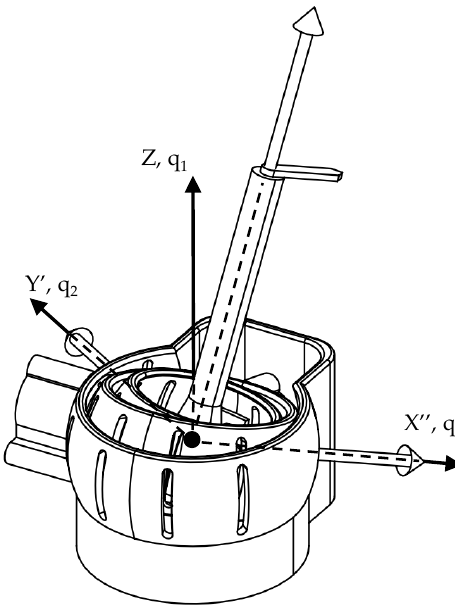
Figure 3. Tait–Bryan angles in the master